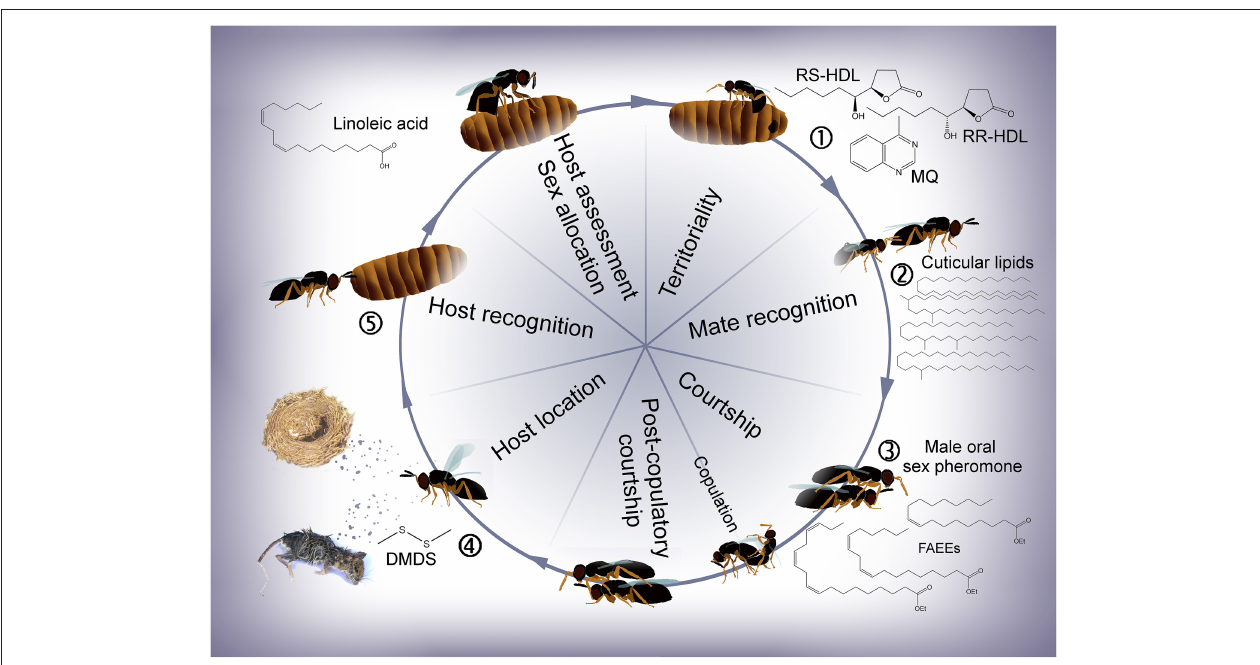
FIGURE 2 | Life cycle of Nasonia with emphasis on the different stages at which semiochemicals are involved. (1) Males apply an abdominal sex pheromone to the natal host and its surroundings to attract and arrest emerging females. (2) Males recognize females based on the females’ cuticular hydrocarbons (CHCs, N. vitripennis ) or cuticular lipids (CLs, = cuticular hydrocarbons + polar lipids, N. giraulti ). (3) During courtship, a male oral sex pheromone is transferred to the female’s antennae, females discriminate between conspecific and heterospecific mating partners and post-copulatory courtship induces a switch in the females’ receptivity. (4) Females find new hosts based on olfactory cues. (5) Chemical stimuli are most likely involved during host recognition, host assessment and sex allocation (according to local mate competition theory). RR-HDL, (4 R ,5 R )-5-hydroxy-4-decanolide; RS-HDL, (4 R ,5 S )-5-hydroxy-4-decanolide; MQ, 4-methylquinazoline; FAEEs, fatty acid ethyl esters; DMDS,